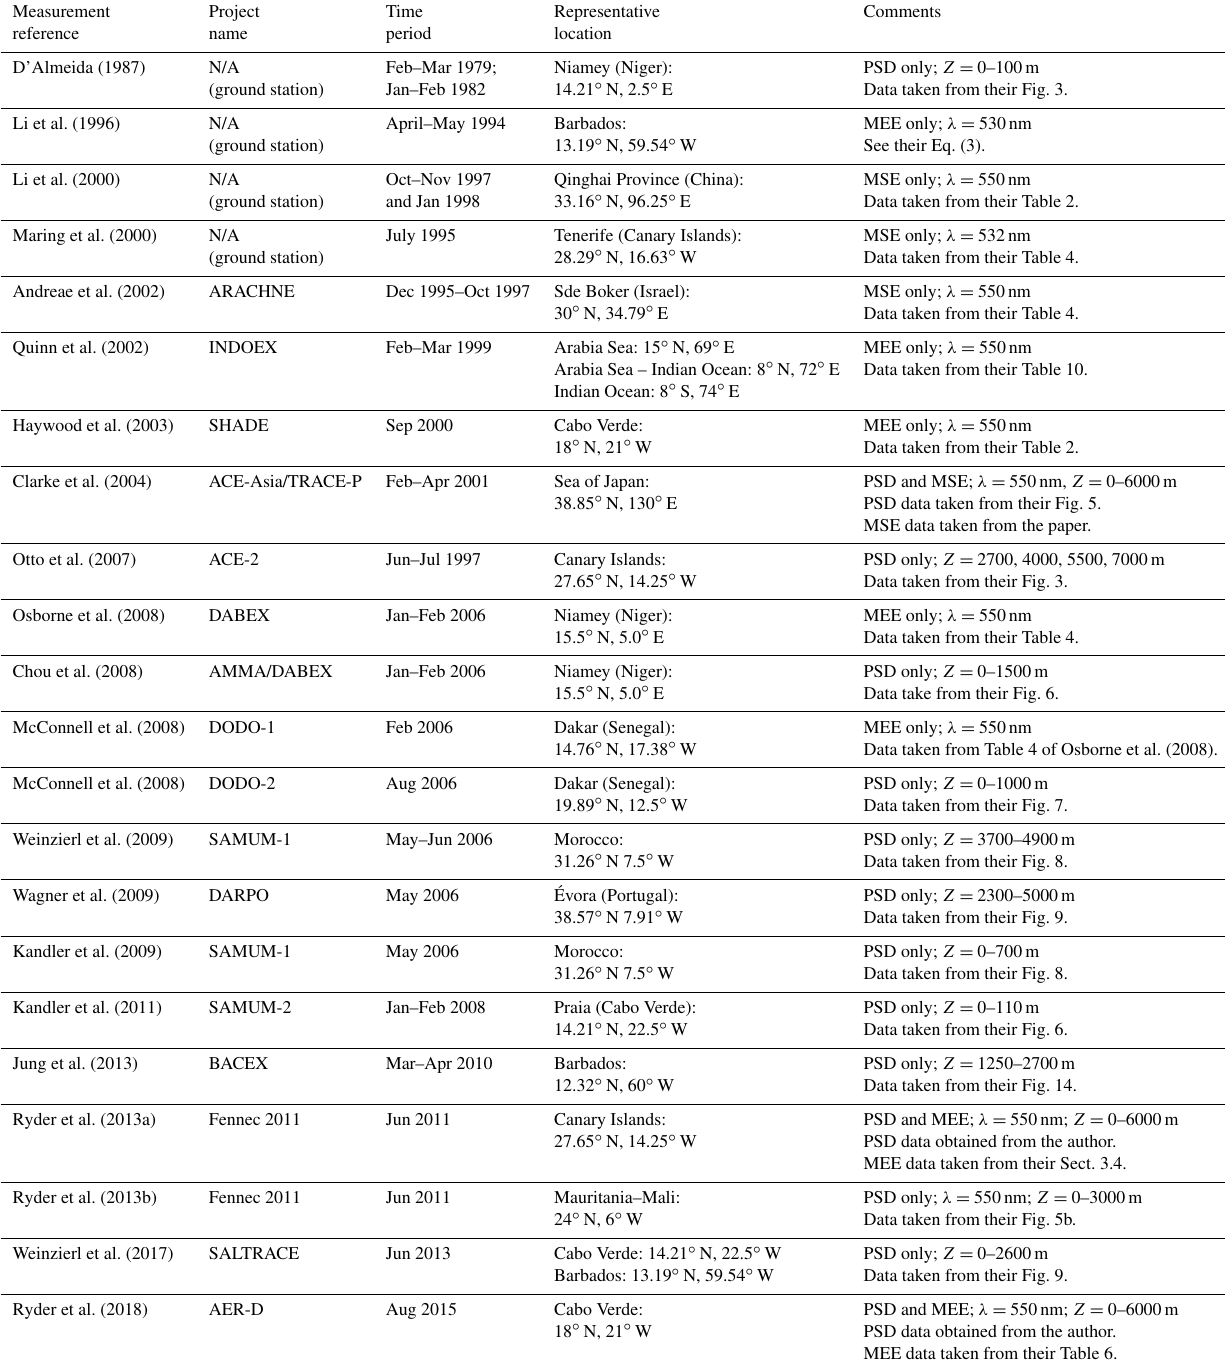
Table 2. Overview of in situ measurements used to evaluate DustCOMM and model ensemble estimates of the dust size distribution and dust mass extinction efficiency (see Sect. 2.4 for details). The label PSD in the last column indicates that we take dust size distribution values from the study. MSE and MEE similarly indicate that we take dust mass scattering or extinction efficiency